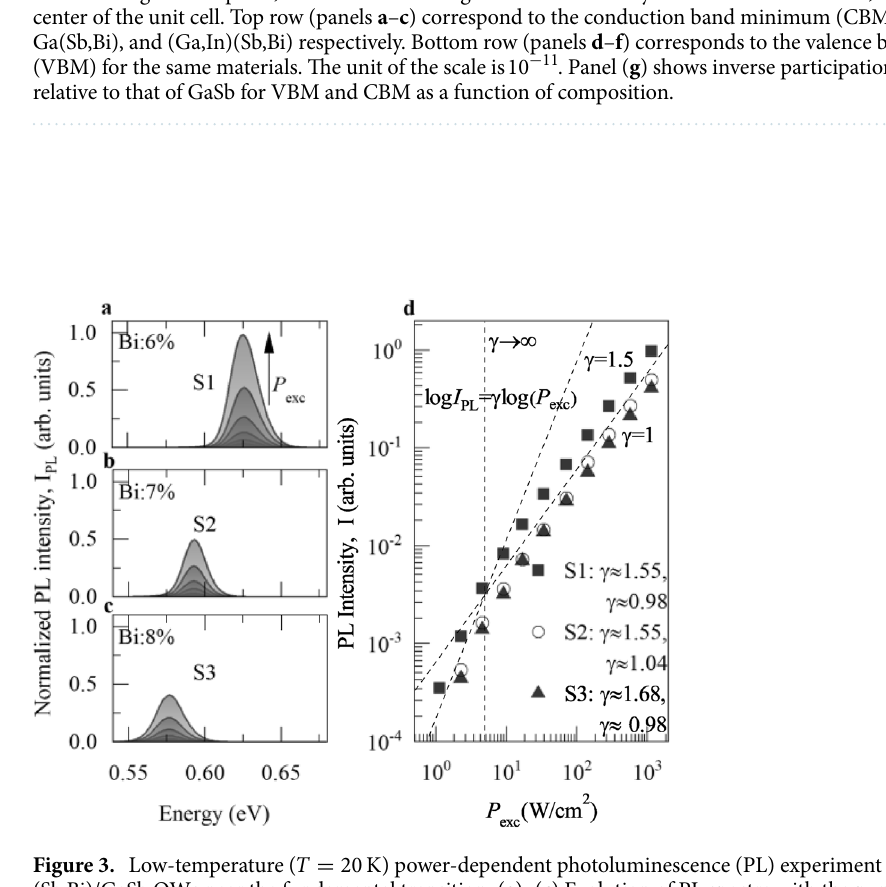
Figure 3. Low-temperature ( T = 20K ) power-dependent photoluminescence (PL) experiment on (Ga,In) (Sb,Bi)/GaSb QWs near the fundamental transition. ( a )–( c ) Evolution of PL spectra with the pumping power density ( P exc ) for the S1, S2, and S3 structure. ( d ) Power-law function dependence for the integrated PL intensity ( I PL ) plotted in the log-log scale (points). Black dashed lines show expected evolution of the log I PL [ log ( P exc ) ] with γ → ∞ , γ = 1.5 , γ = 1 . Legend contains the extracted γ parameter after fitting data points with the power-law function. Experiment employed the continuous-wave excitation at E exc ≈ 2.33 eV . The P exc ranges from ≈ 1.13 to 1132 Wcm − 2